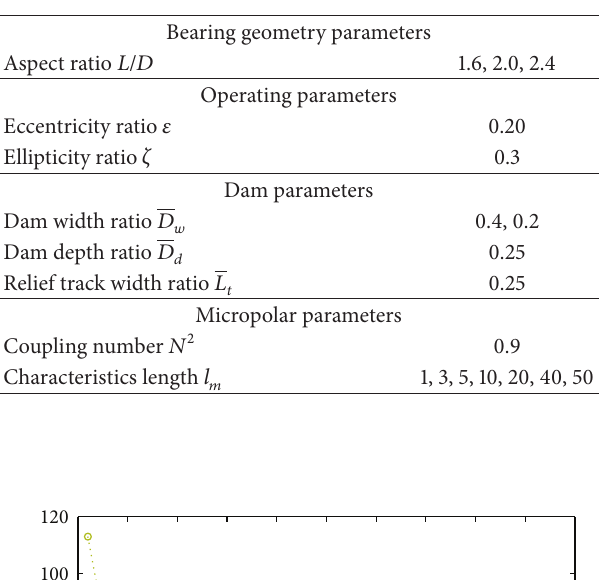
Table 1: Parameters for two-lobe pressure dam bearing.